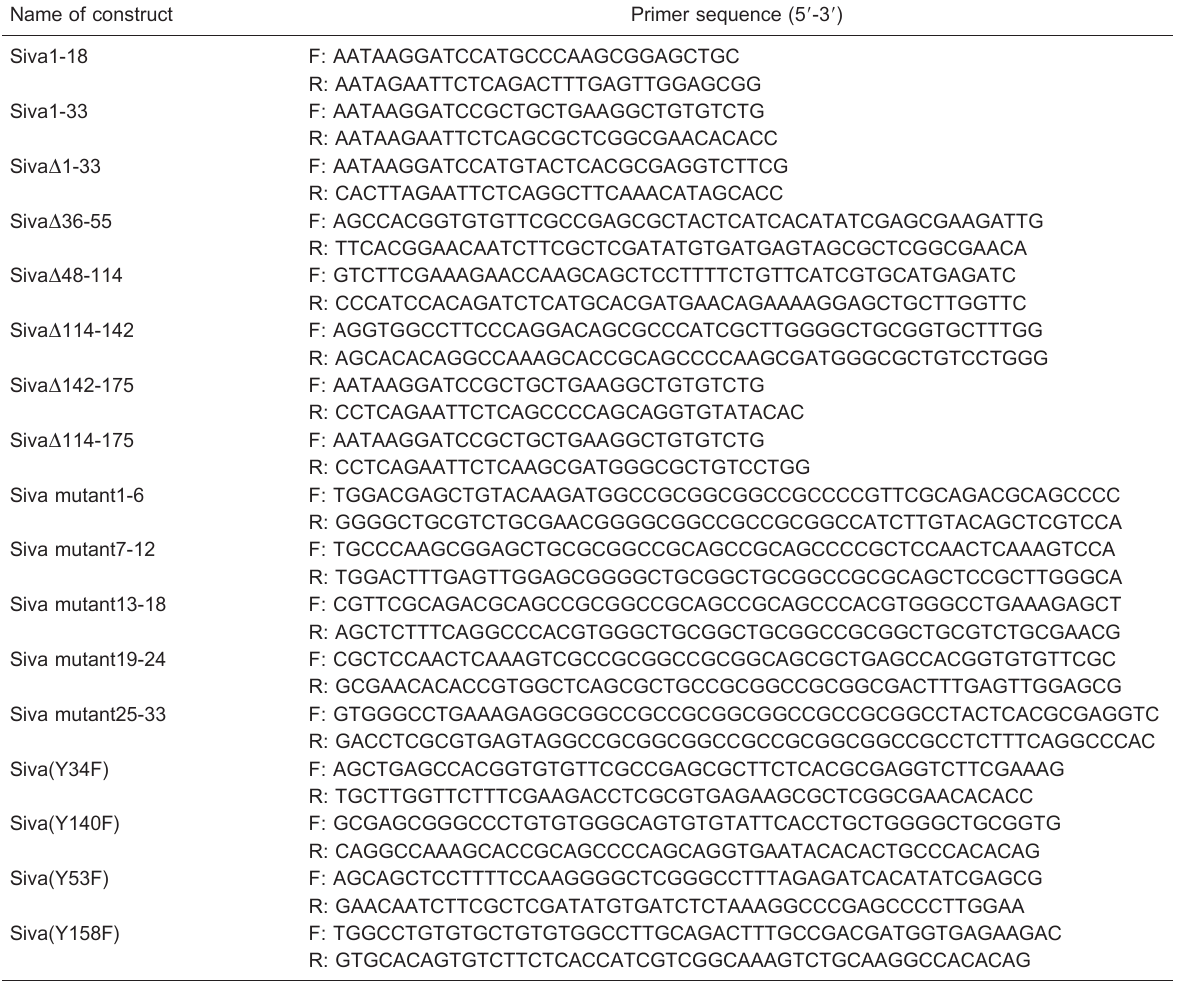
Table 1. Primer sequences used for Siva-1 mutations. Name of